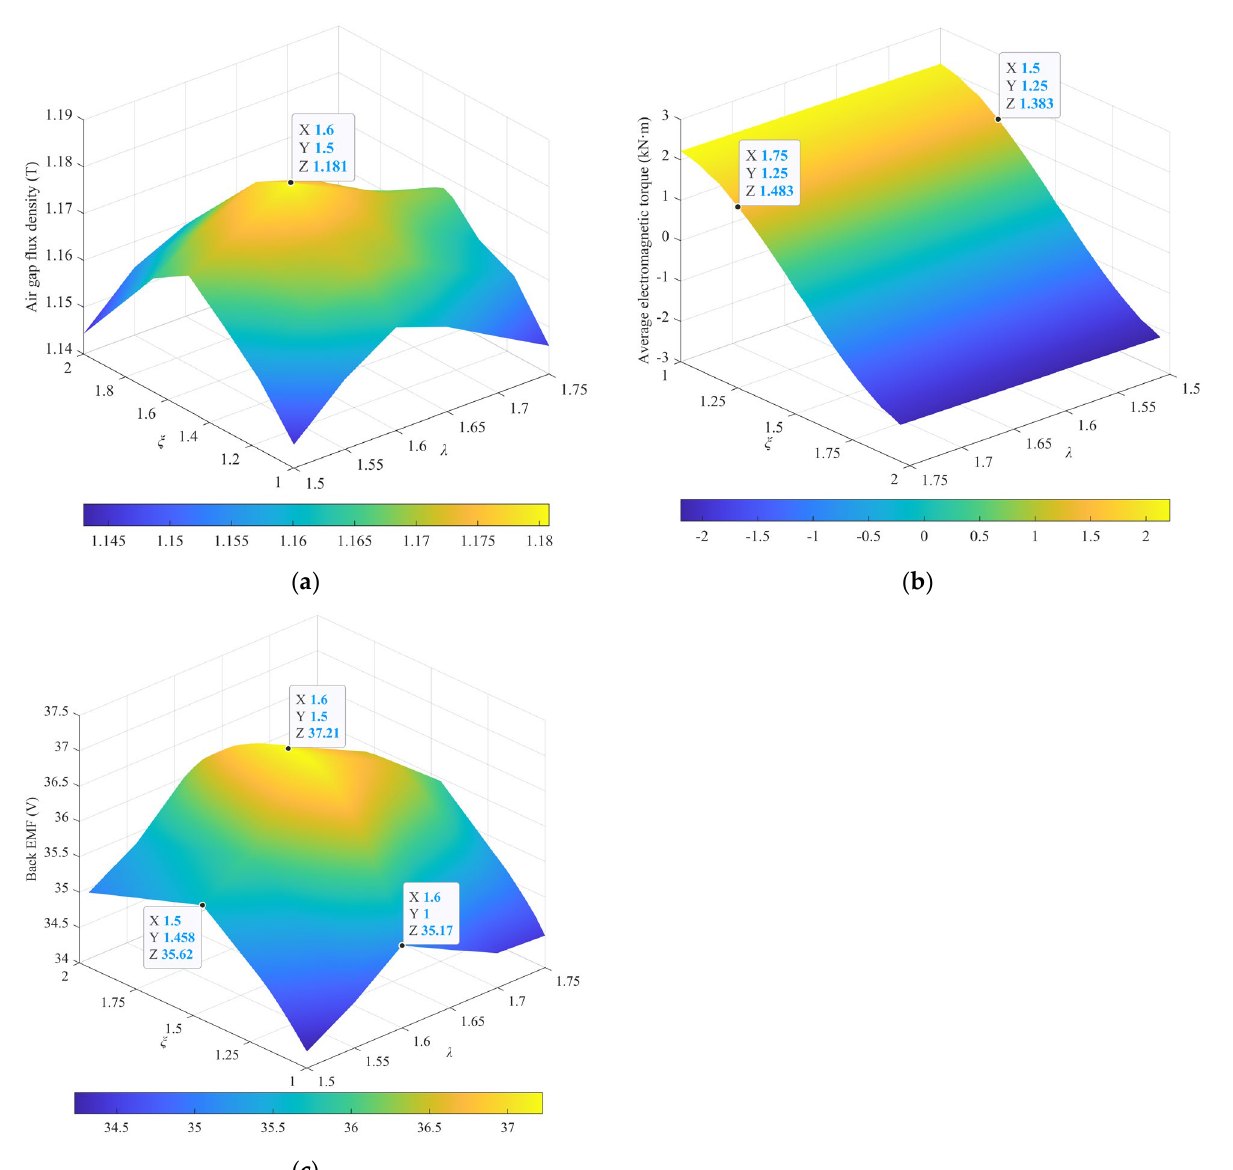
Figure 12. Surface chart of electromagnetic characteristics with λ and ξ: ( a ) fundamental wave amplitude of air-gap flux density; ( b ) electromagnetic torque; ( c ) fundamental wave amplitude of no-load back EMF.